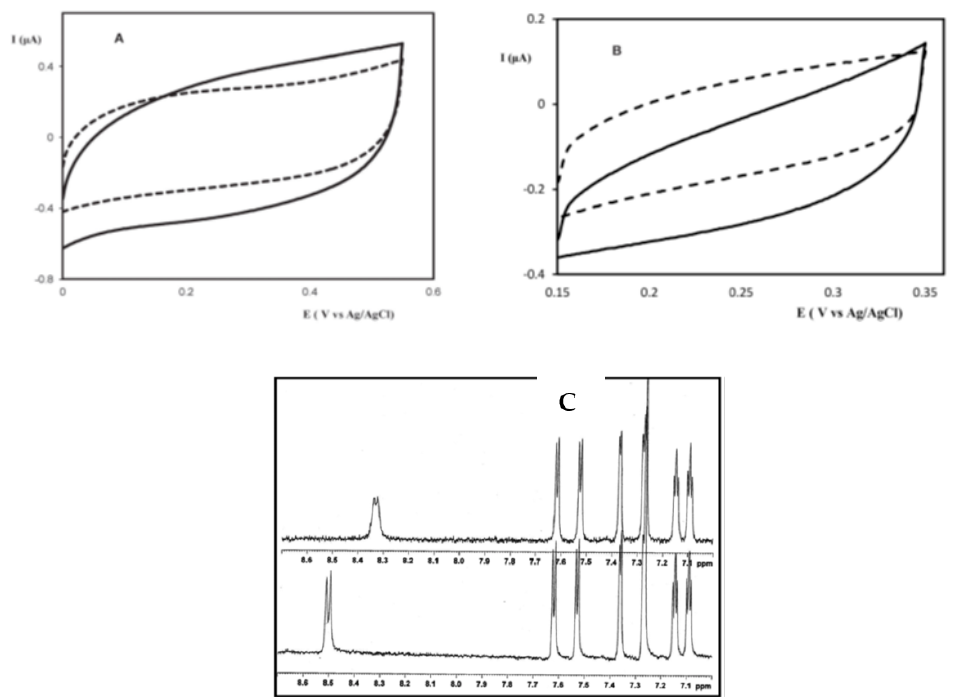
Figure 2. ( A ) Capacitive current of poly4 - Pt (solid line) at concentrations 0 and 1 M of LeuOMe (dash line), ( B ) The capacitive current of poly3-Pt before (solid line) and after (dash line) addition of LeuOMe (1 mM), ( C ) 1 H-NMR of 1 in the absence (top) and in the presence (bottom) of one equivalent of LeuOMe. Reprinted with permission from reference [47]. Copyright 2014 The Royal Society of Chemistry.